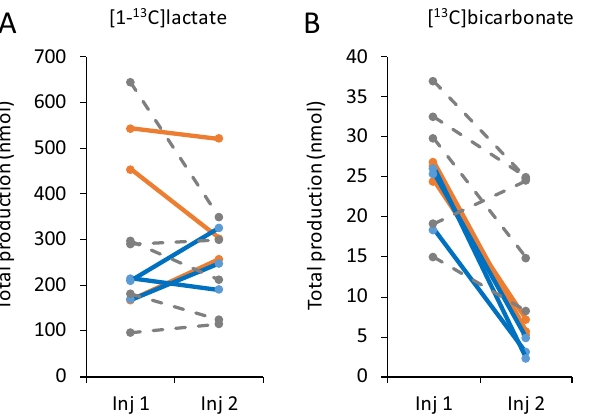
Figure 4. The total apparent production of [1- 13 C]lactate and [ 13 C]bicarbonate prior to and following incubation with TTX, OLI, and aCSF (control). ( A ) The total production of [1- 13 C]lactate. ( B ) The total production of [ 13 C]bicarbonate. TTX, tetrodotoxin, solid red lines; OLI, oligomycin, solid blue lines; Control, regular aCSF, dashed grey lines; Inj1, rates calculated on the first injection following perfusion with regular CSF; Inj2, rates calculated on the second injection, i.e. following perfusion with aCSF supplemented with TTX, OLI, or without supplements